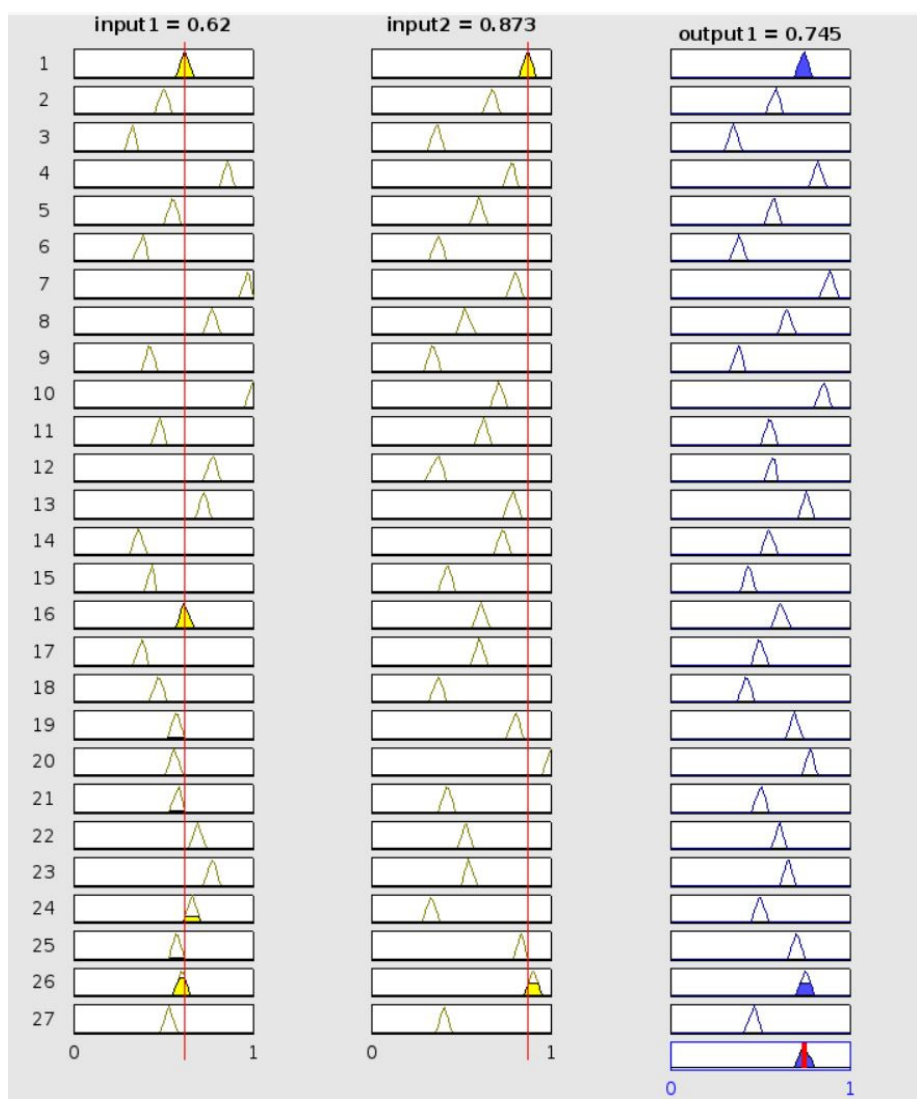
Figure 8. Fuzzy logic rules viewer for Experiment No. 1 . Table 6. Grey-fuzzy reasoning grades (GRFC) and rank.